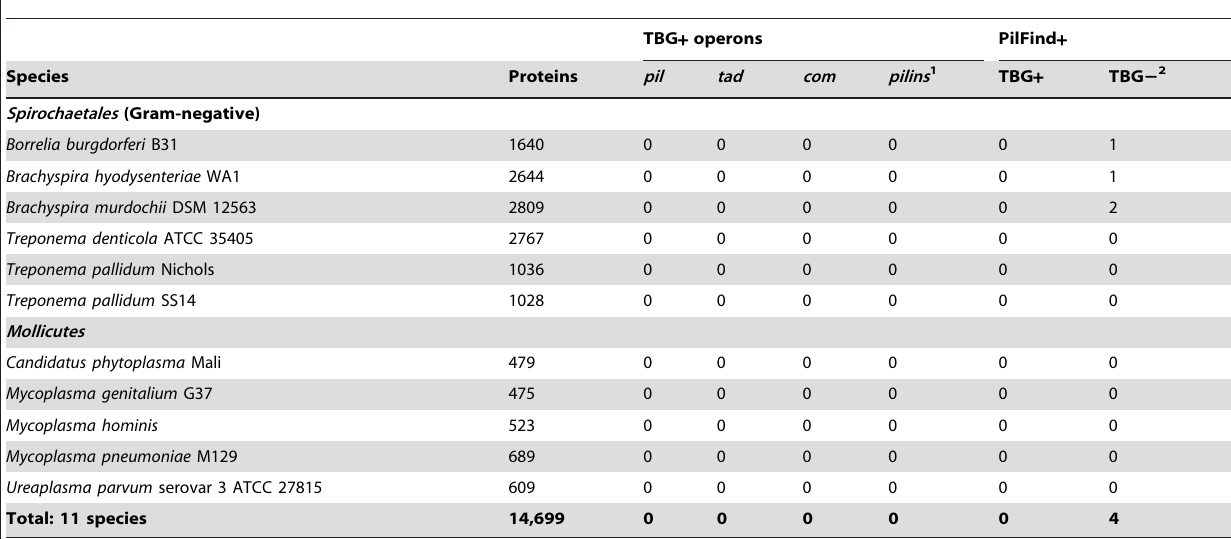
Table 3. Bacteria lacking TFP biosynthetic genes used to construct a negative training